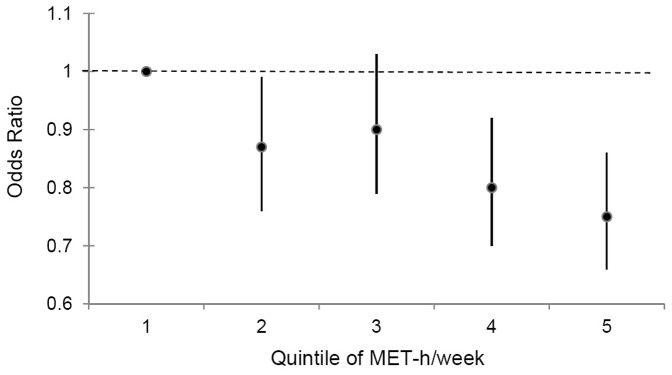
Odd ratios (95% CIs) of MetS associated with quintile of MET-h/week.Odds ratios were estimated by multivariate logistic regression adjusted for age, sex, education levels, smoking, alcohol drinking, use of antihypertension drugs, aspirin, glucose lowering drugs and lipid-lowering drugs, family history of CVD, stroke and diabetes mellitus, and meat intake quintile, fruit and vegetable intake quintile, and consumption of nuts quintiles. Solid round spots denote the point estimates of the odds ratio and vertical lines represent 95% CIs.